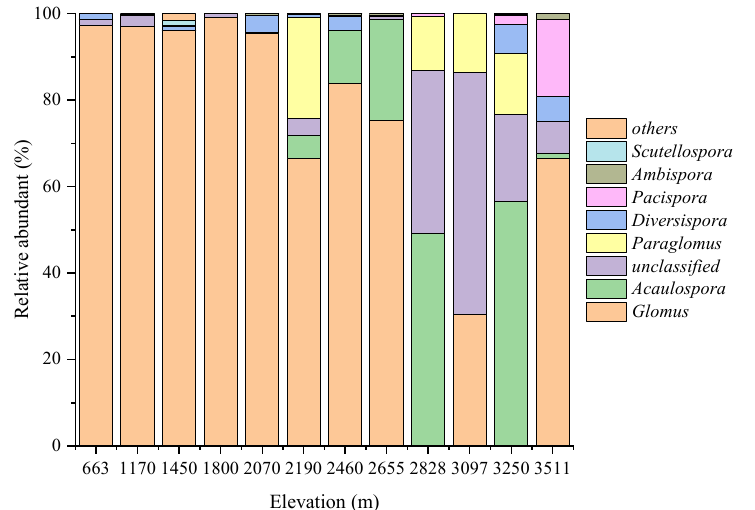
Figure 2. Relative abundance of genera identified based on different altitudes at the genus level. Note: The genus, whose abundance was less than 1%, were collectively classified as others.